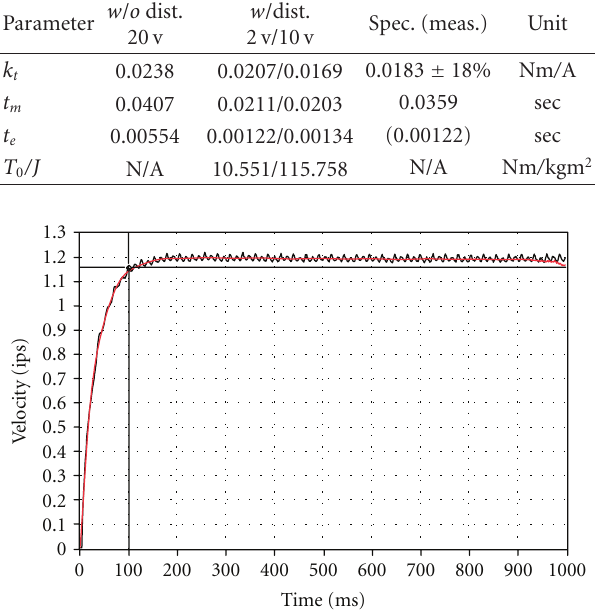
Figure 1: Approach w/ consideration of disturbance under 2volt input: black, measurement: red, power series